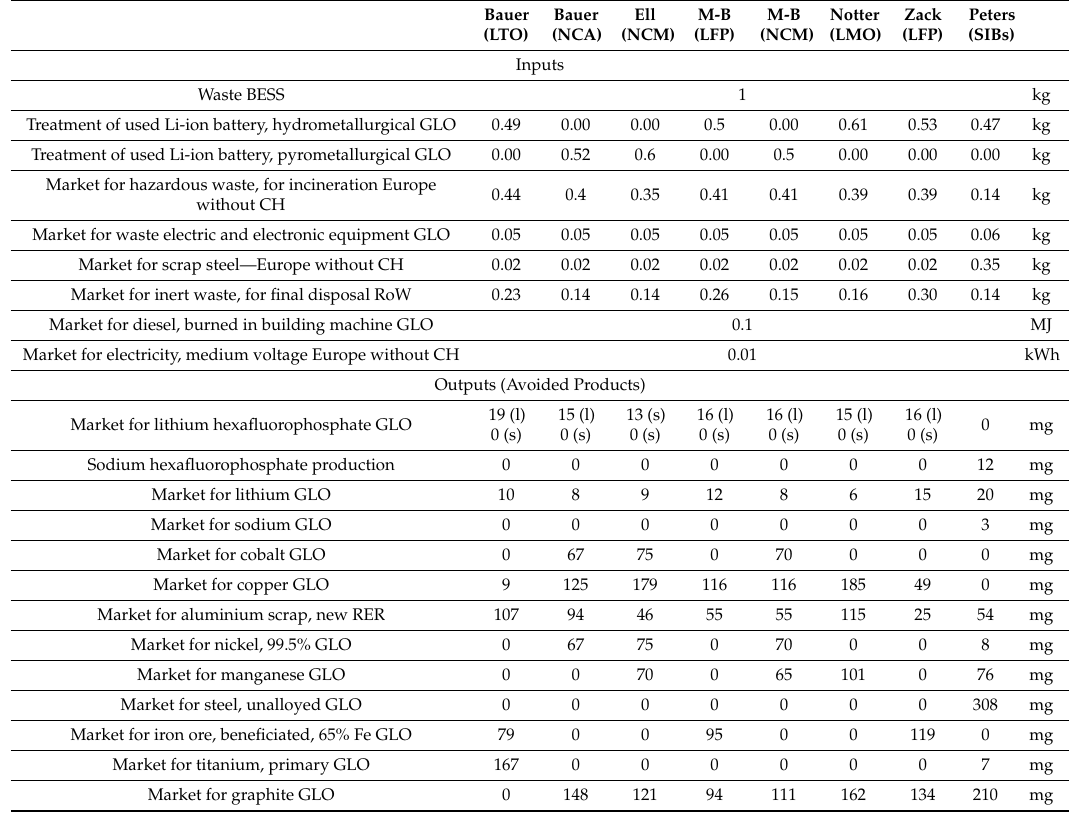
Table 4. LIBs, SSLIBs and Peters (SIB) inventory for